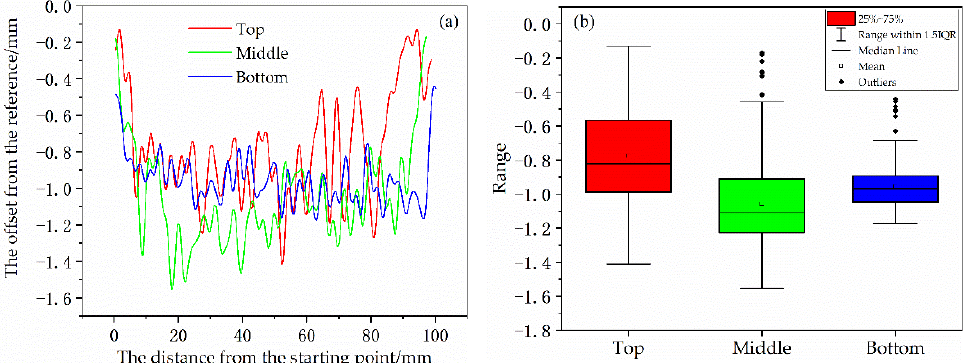
Figure 6. Deformation ( a ) and deformation statistics ( b ) of different positions of thin-walled parts.